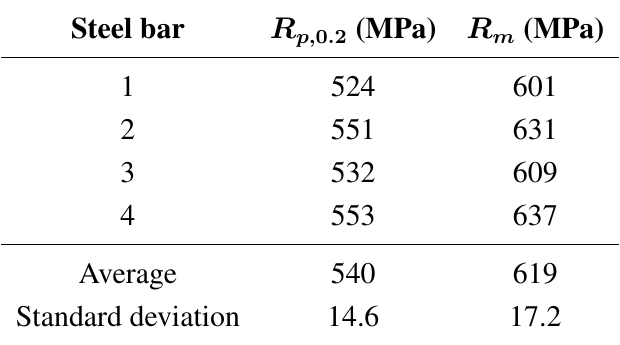
, and on the testing cm,cube, 28